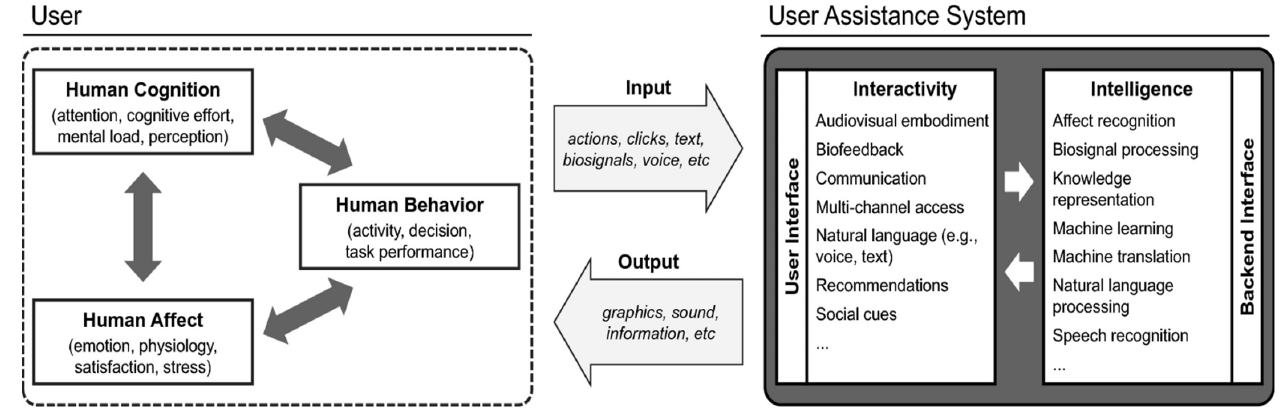
Figure 16. An ideal interaction system between a user and user assistance system